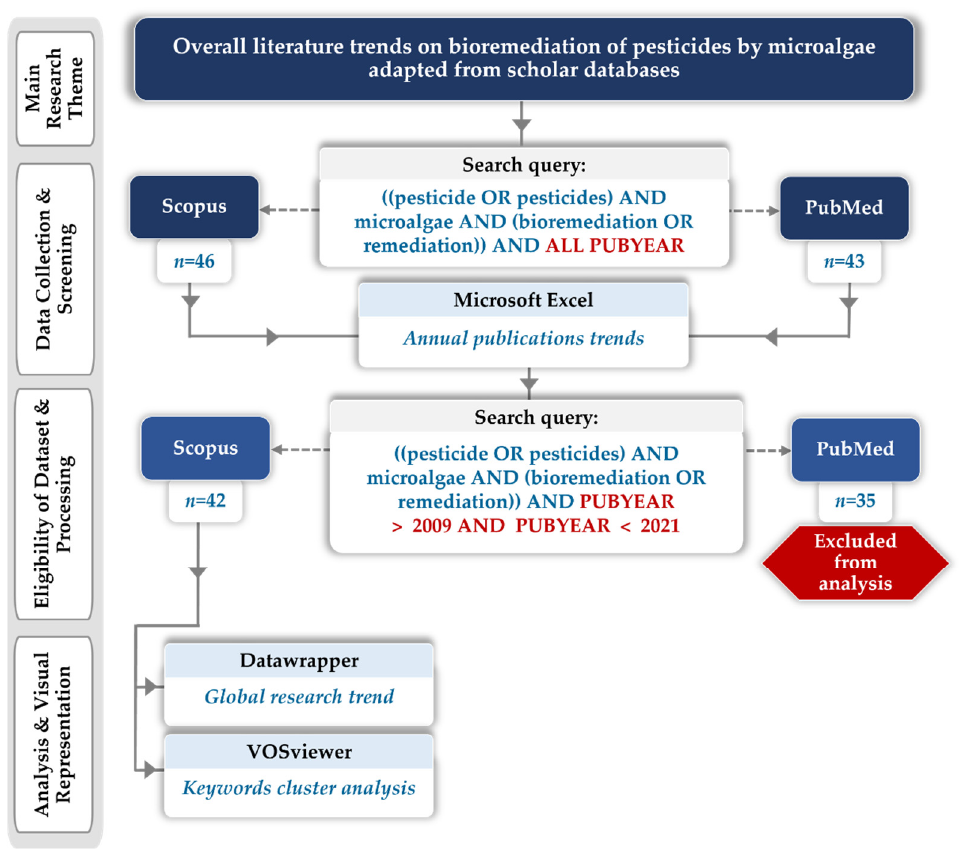
Figure 1. Bibliometric protocol for identifying and processing scholarly documents based on re- search topic.